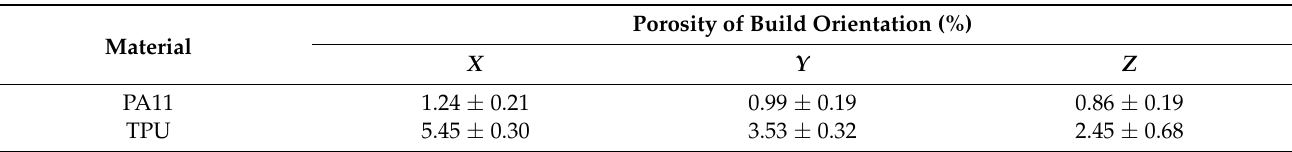
Figure 6. XPS analyses of powders and specimens: ( a , b ) wide scan; ( c , d ) high-resolution spectra of carbon chemical state; ( e , f ) high-resolution spectra of oxygen chemical state. Table 3. Chemical composition of chemical bonds for both powders and specimens. Table 4. Porosity content of flexural specimens calculated from micro-CT